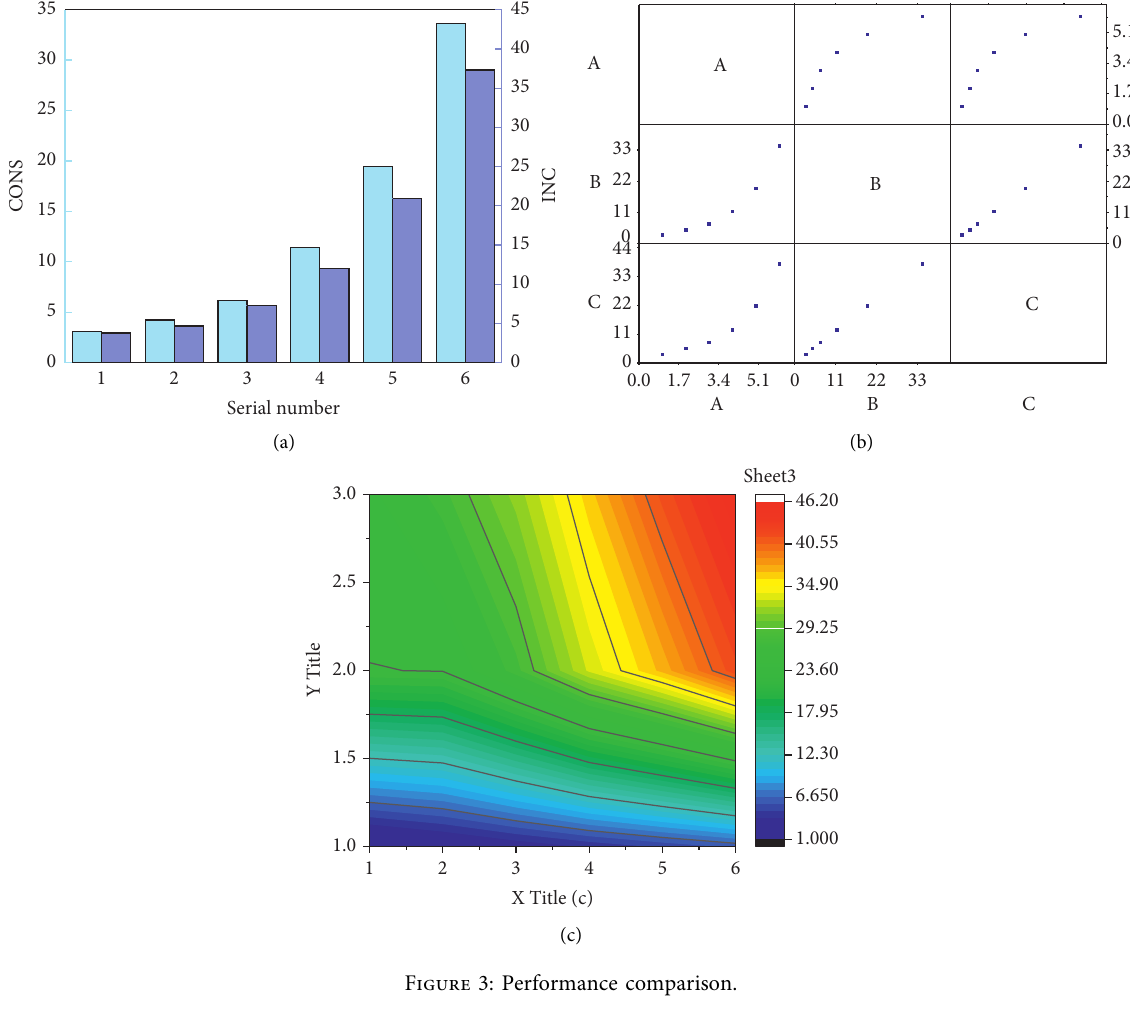
Figure 3: Performance comparison.